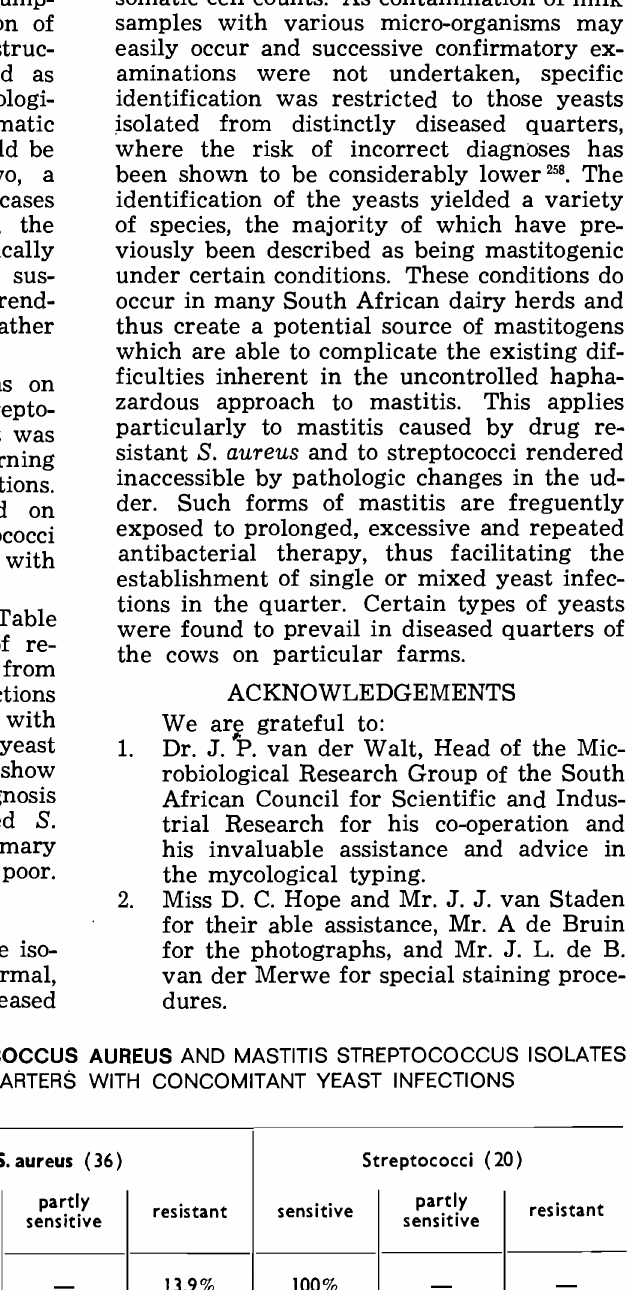
Table 6: DRUG SENSITIVITY OF STAPHYLOCOCCUS AUREUS AND MASTITIS STREPTOCOCCUS ISOLATES FROM SEVERELY DISEASED QUARTERS WITH CONCOMITANT YEAST INFECTIONS